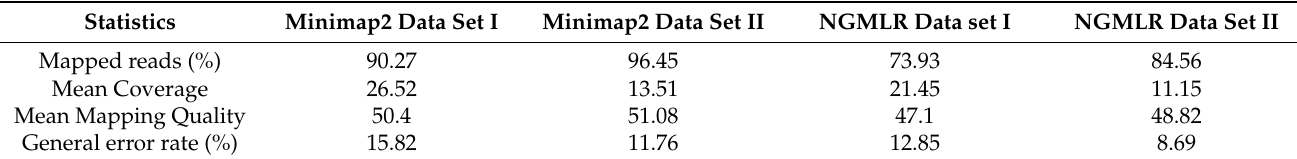
Table 6. Statistical parameters obtained with Qualimap for the quality of the guided assemblies performed with the minimap2 and NGMLR applications using the two